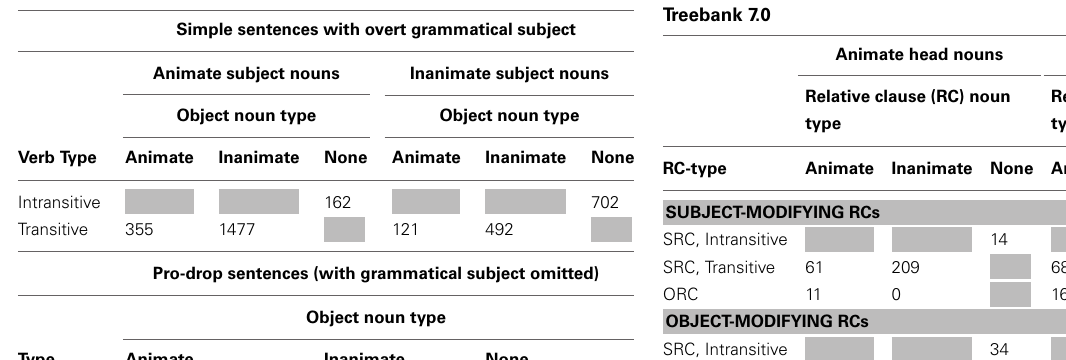
Table 2 | Token frequencies of overt subject simple sentences and pro-drop sentences found in Chinese Treebank 7.0.